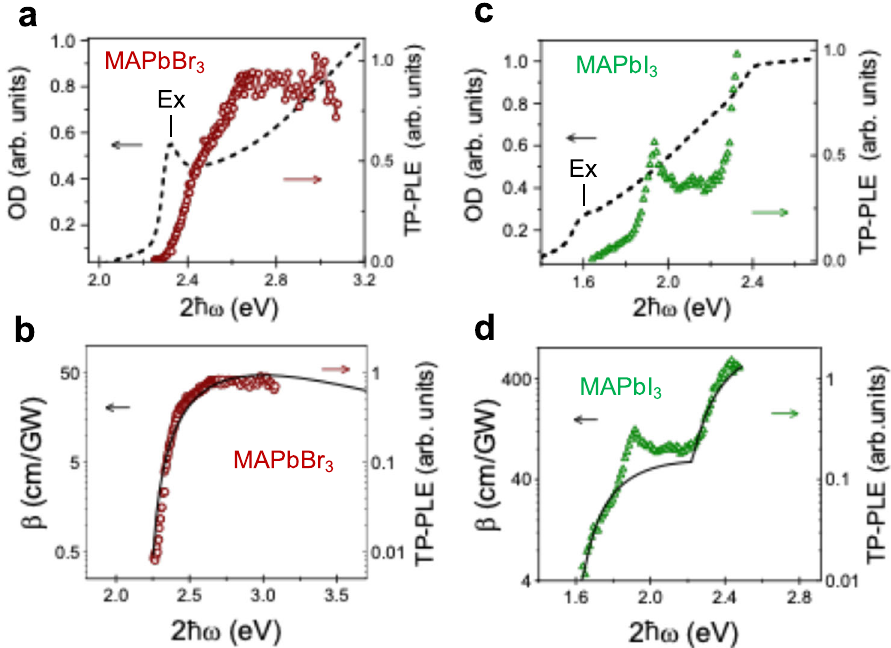
Fig. 3 Two-photon photoluminescence excitation (TP-PLE) spectra of HOIP crystals measured at room temperature compared to the absorption spectra and model calculations. TP-PLE spectrum of MAPbBr 3 (brown circles) compared to a the absorption spectrum of the corresponding thin fi lm (dashed line) and b theoretical calculations for the TPA response β ð ω Þ excluding the Rashba effect (solid black line) plotted on a semi-log scale. TP-PLE spectrum of MAPbI 3 (green triangles) compared to c the absorption spectrum of a thin fi lm (dashed line) and d theoretical calculations for the TPA response β ð ω Þ excluding the Rashba effect (solid black line) plotted on a semi-log scale. The TP-PLE spectra are plotted vs. twice the excitation energy, 2 _ ω ; whereas the absorption spectra are plotted vs. _ ω . The exciton region (Ex) is indicated in ( a and c